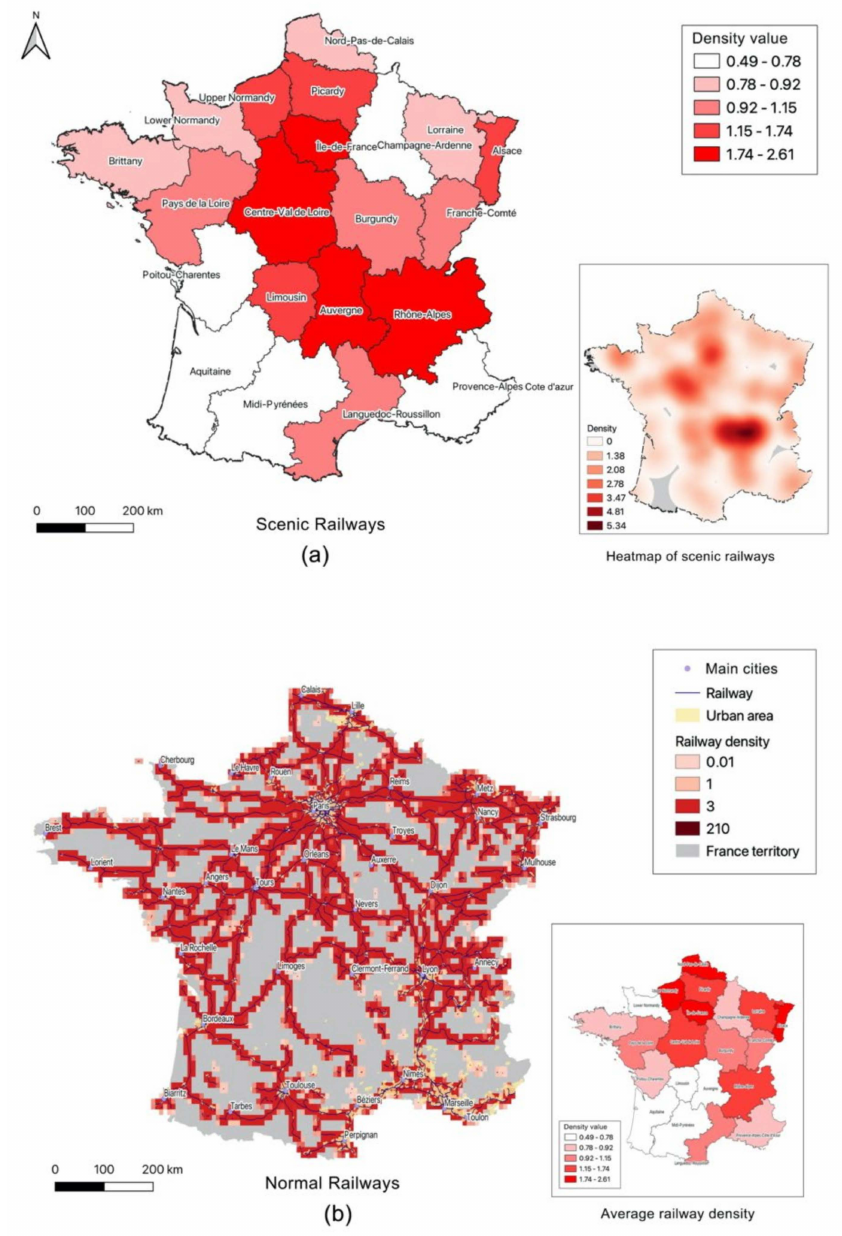
Figure 6. KDE of scenic railway ( a ); line density of normal railways in France ( b